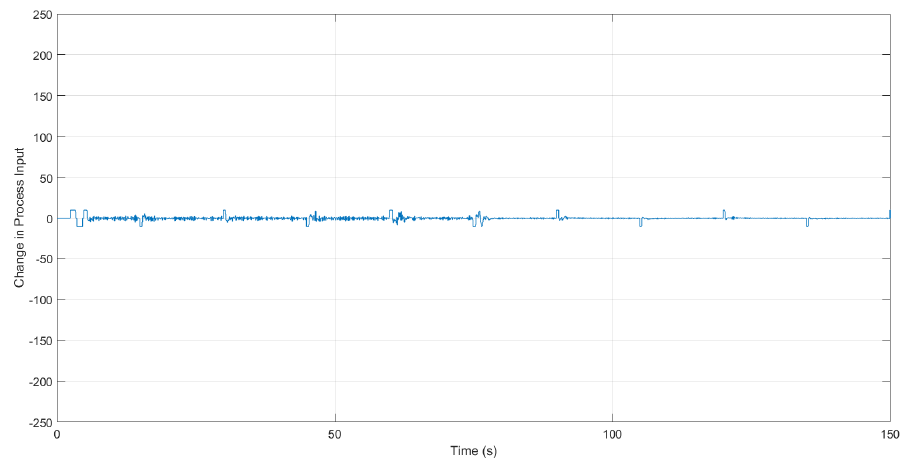
Figure 11. Rate-of-change of applied controls (process input) in the constrained Figure 11. Rate ‐ of ‐ change of applied controls (process input) in the constrained case.